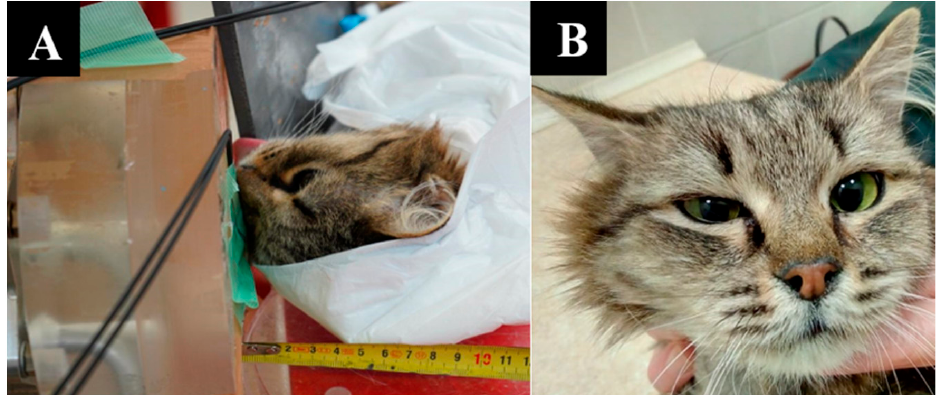
Figure 5. A cat named “Sabrina”. ( A )—positioning of the animal during the irradiation session. ( B )—The state of the animal one week after irradiation.